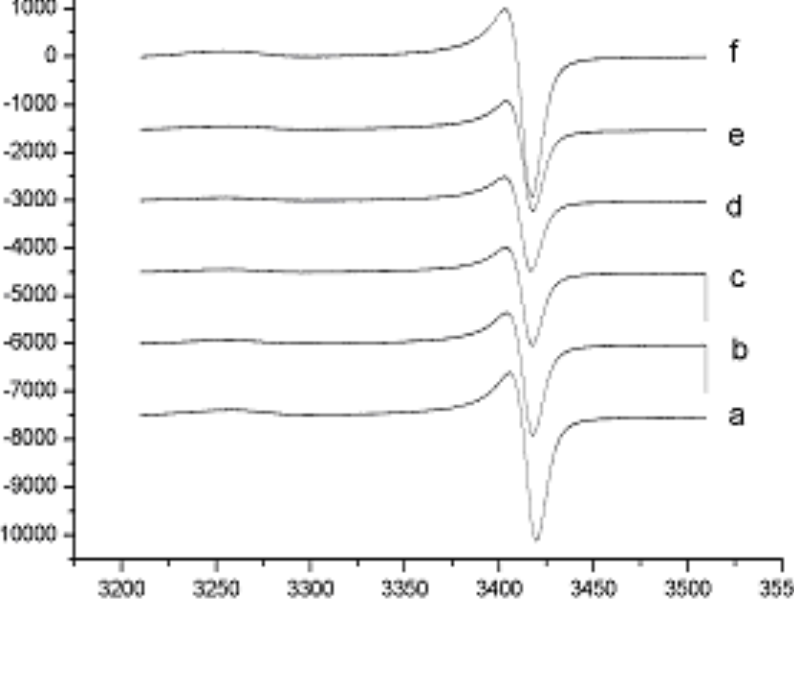
Figure 3. The ESR spectrum of superoxide anion radicals and the dose dependent scavenging effects of mistletonone. Superoxide anion radicals were generated using the NaOH/DMSO system. ESR conditions were as described in the text. a ~ e were the scavenging effects of mistletonone in the concentrations of 0.06, 0.12, 0.18, 0.24, and 0.30 mM, respectively; f: